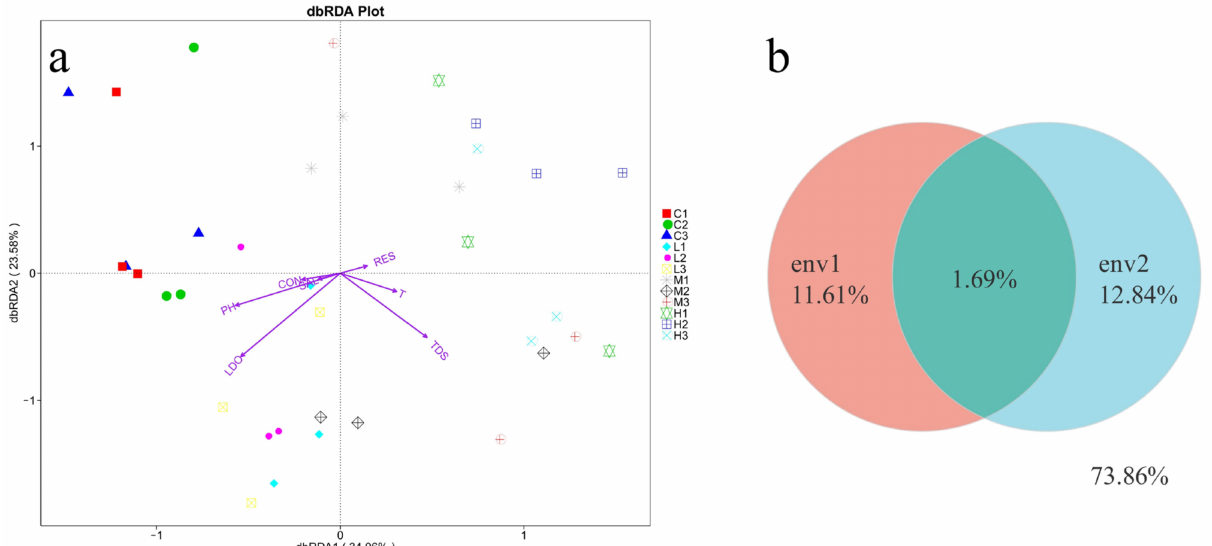
Figure 8. ( a ) Redundancy analysis (RDA) analyzed the correlation between bacterial Alpha diversity and environmental factors (temperature, salinity, dissolved oxygen, pH, etc.), each dot in the figure represents a single sample, and samples from the same group are represented using the same color, the direction indicated by the arrow indicates the trend of environmental factors with length proportional to correlation. ( b ) The circle overlap indicates the common amount of interpretation shared between the first set of environmental factors and the second group, and the circle indicates the uninterpretable